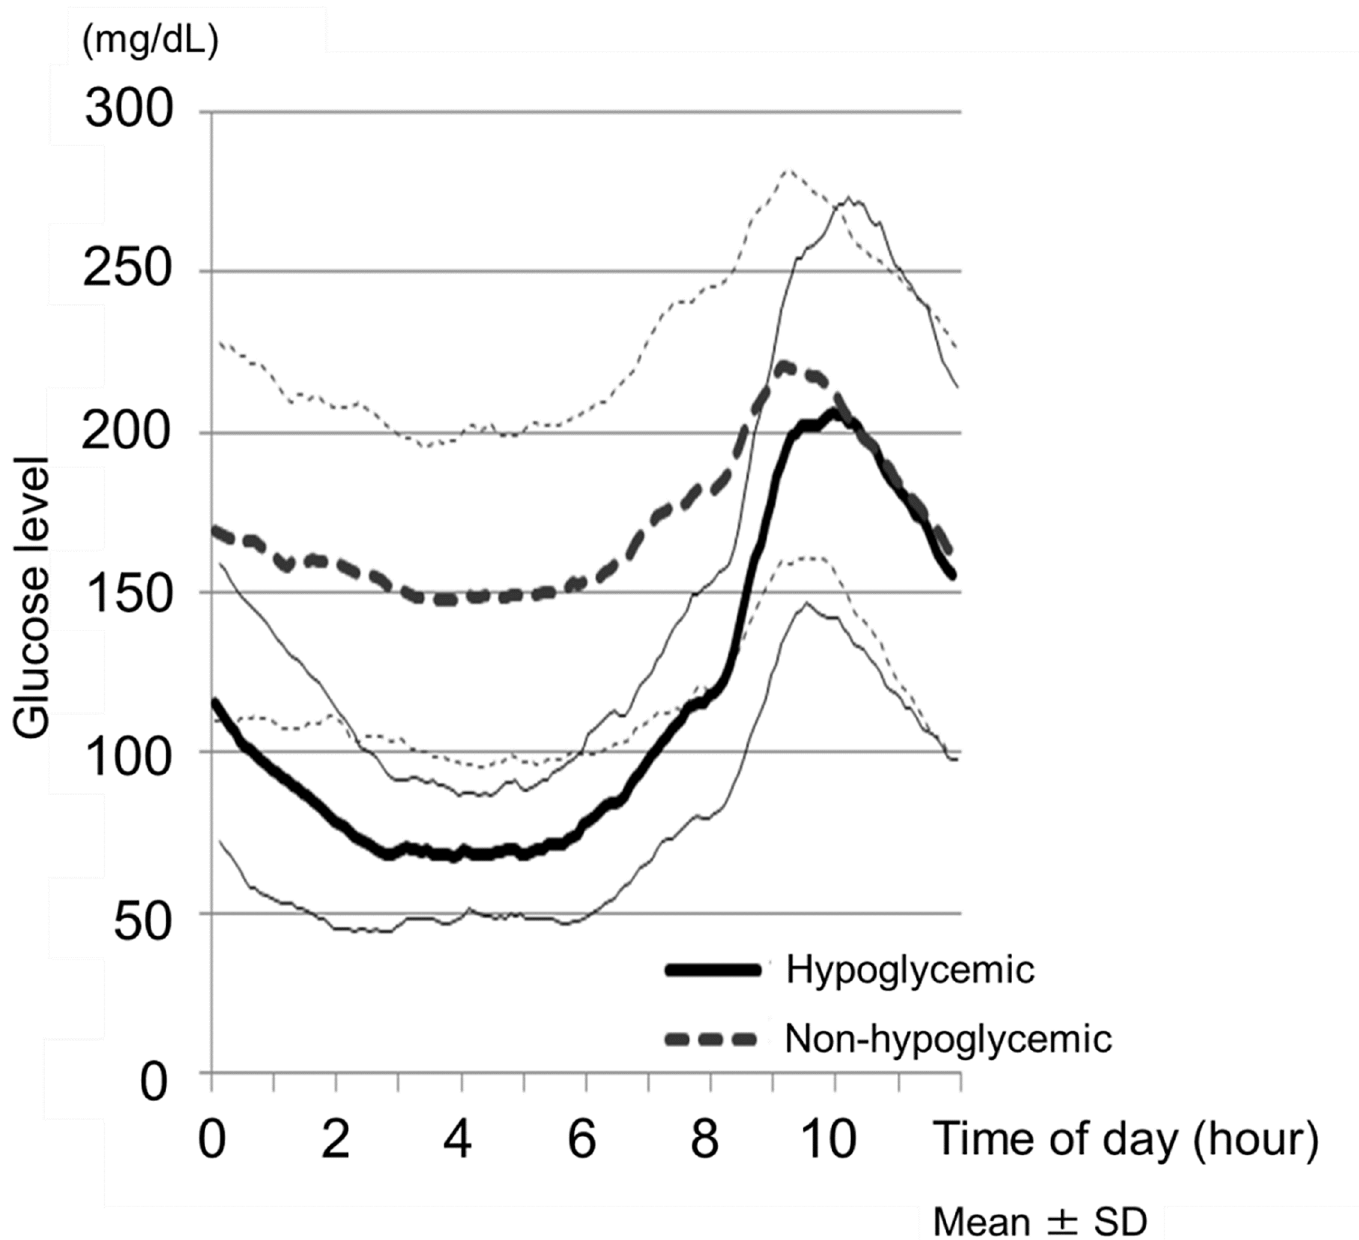
Fig 1. Glucose Profiles Showing Nighttime to Post-Breakfast Glucose levels. Hypoglycemic patients (n = 23); Non-hypoglycemic patients (n =